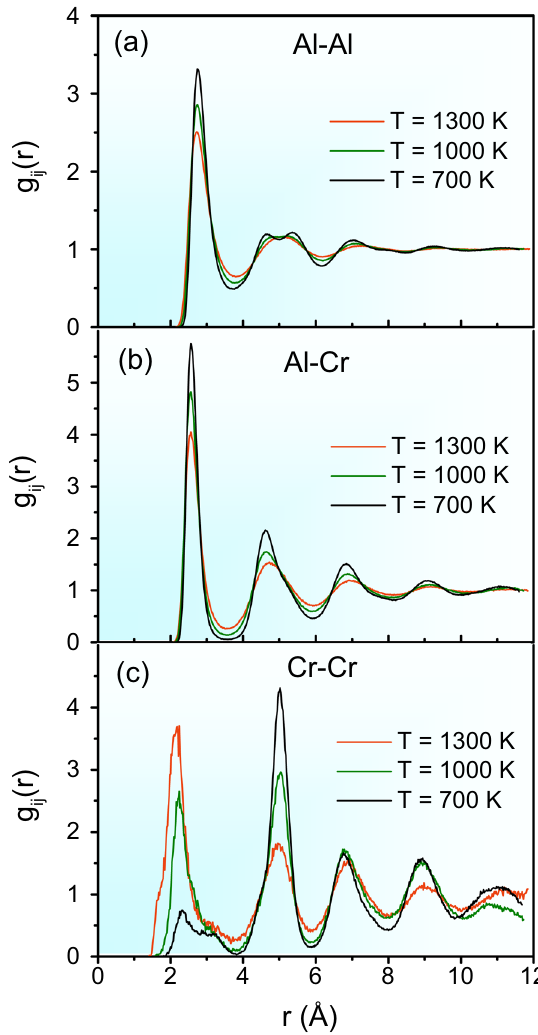
Fig. 5 Calculated partial pair-distribution functions of Al − Cr binary alloy from ab initio molecular dynamics simulations for various temperatures: a Al − Al, b Al − Cr, and c Cr − Cr. The data for 700 and 1000 K are taken from ref.